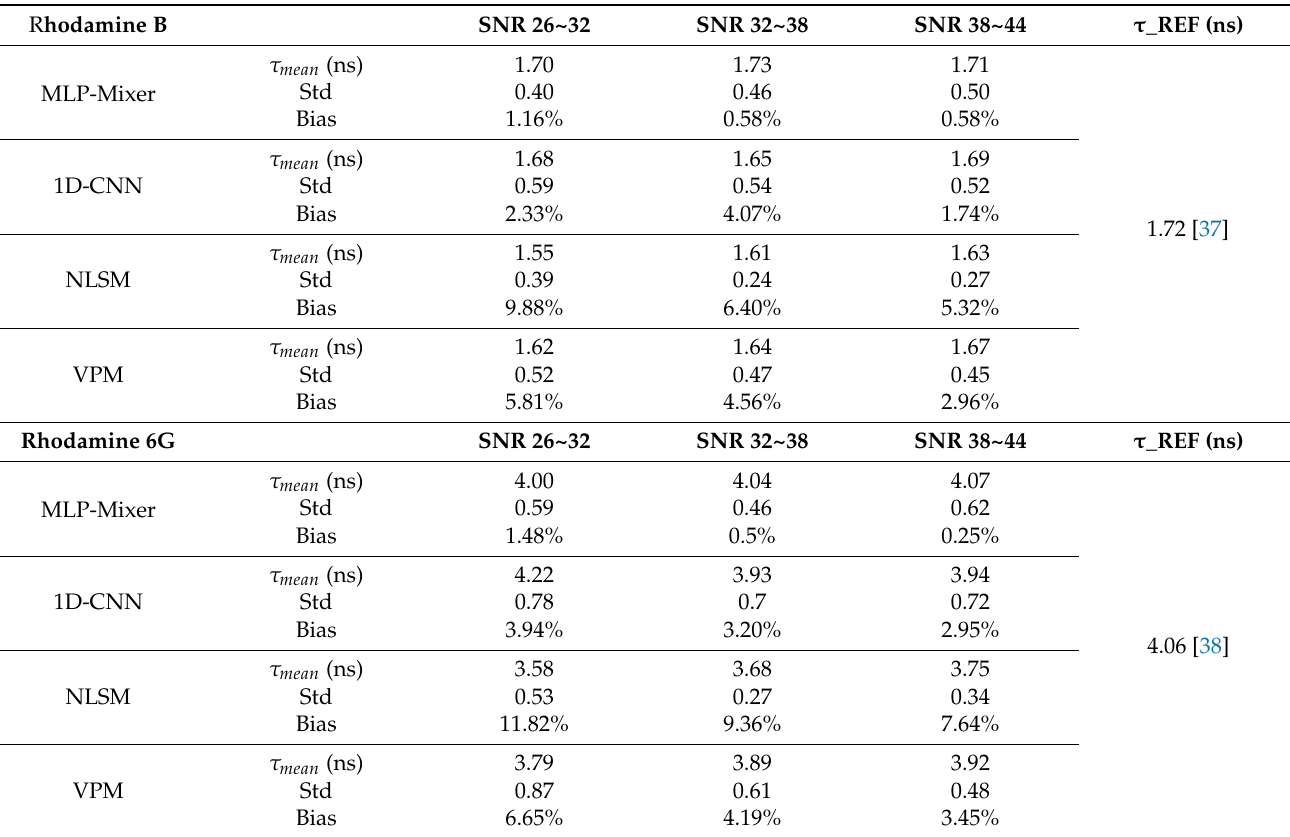
Table 2. Rhodamine B and 6G lifetimes with the MLP-Mixer, 1D-CNN, NLSM, and VPM.